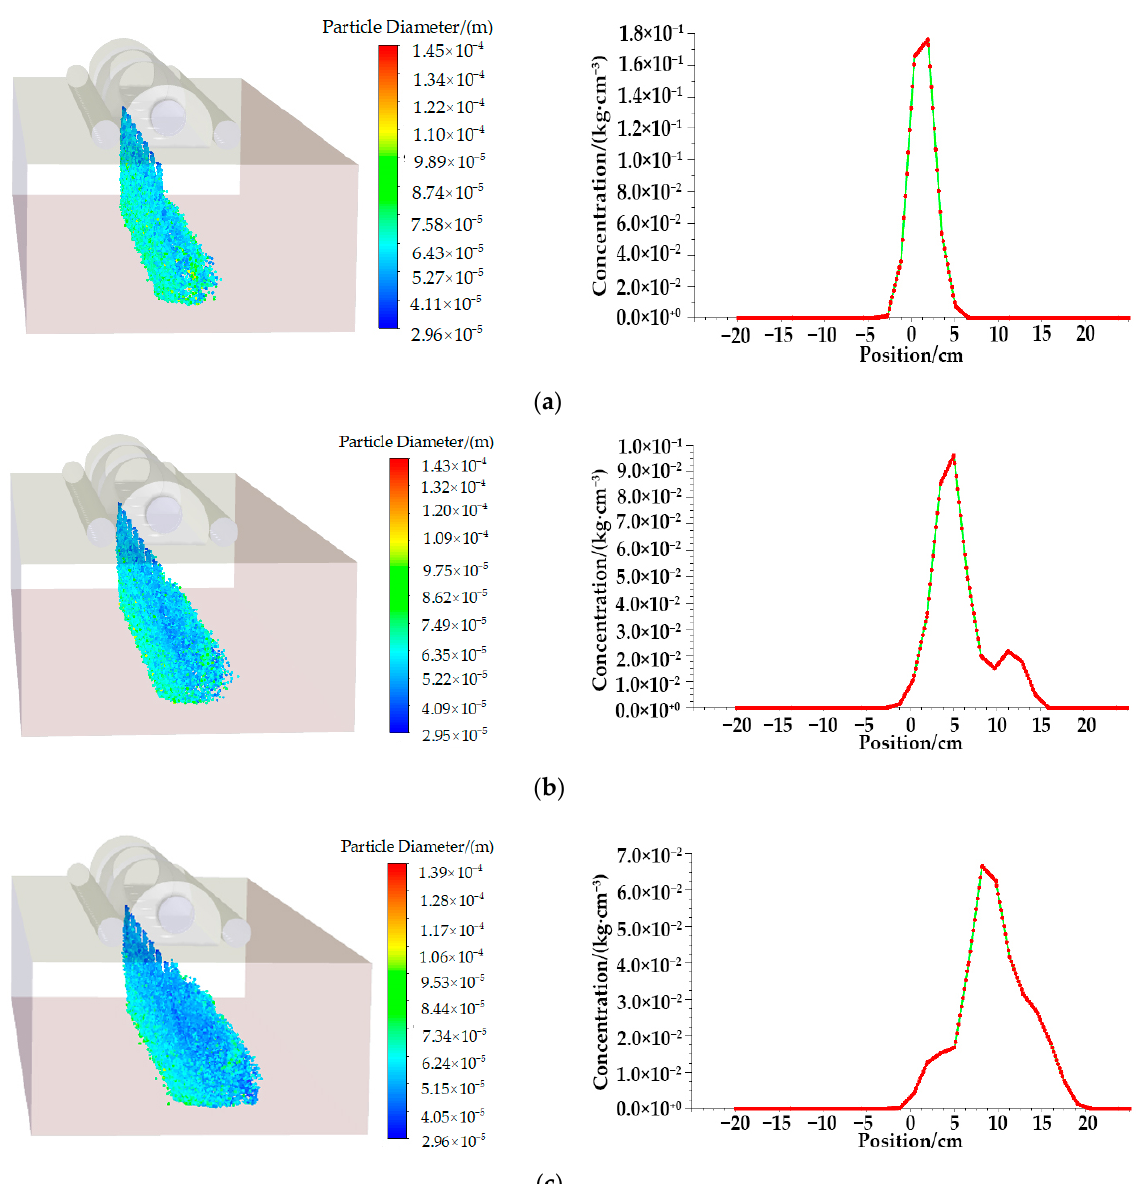
Figure 11. Droplet spatial distribution and the droplet concentration in the calibration line with different crosswind wind speed; 2 m/s ( a ); 3 m/s ( b ); 4 m/s ( c ).